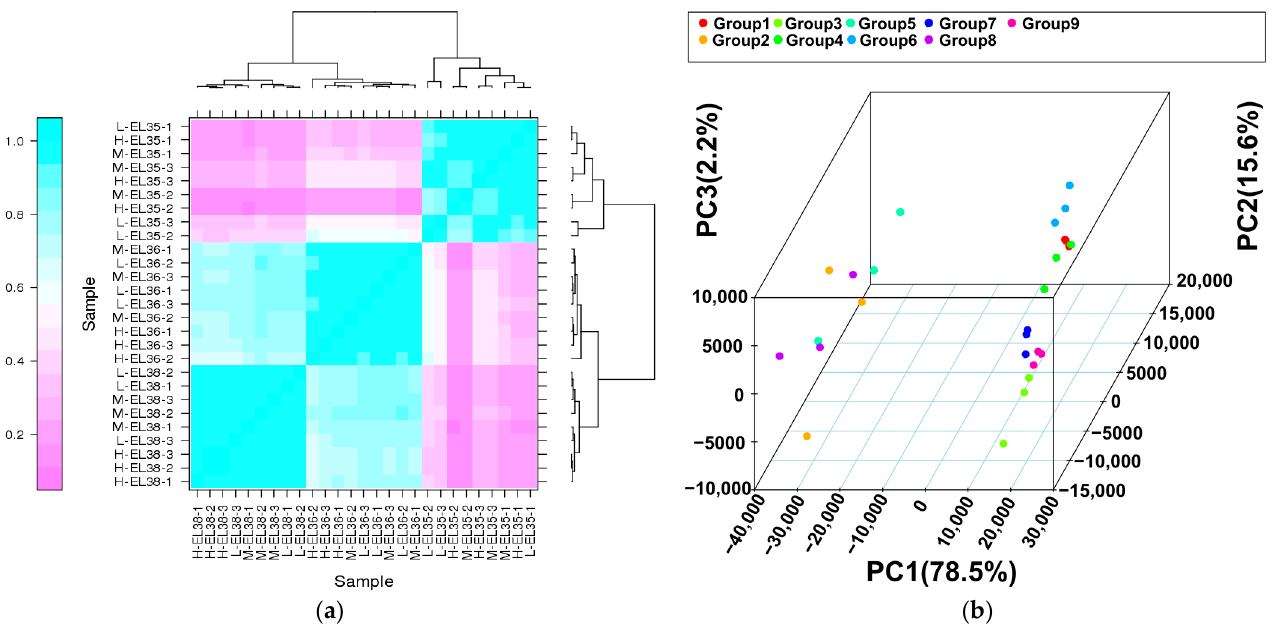
Figure 2. Heatmap clustering showing correlation among samples based on global expression profiles ( a ) and principal component analysis of the samples based on gene expression profiles ( b ).